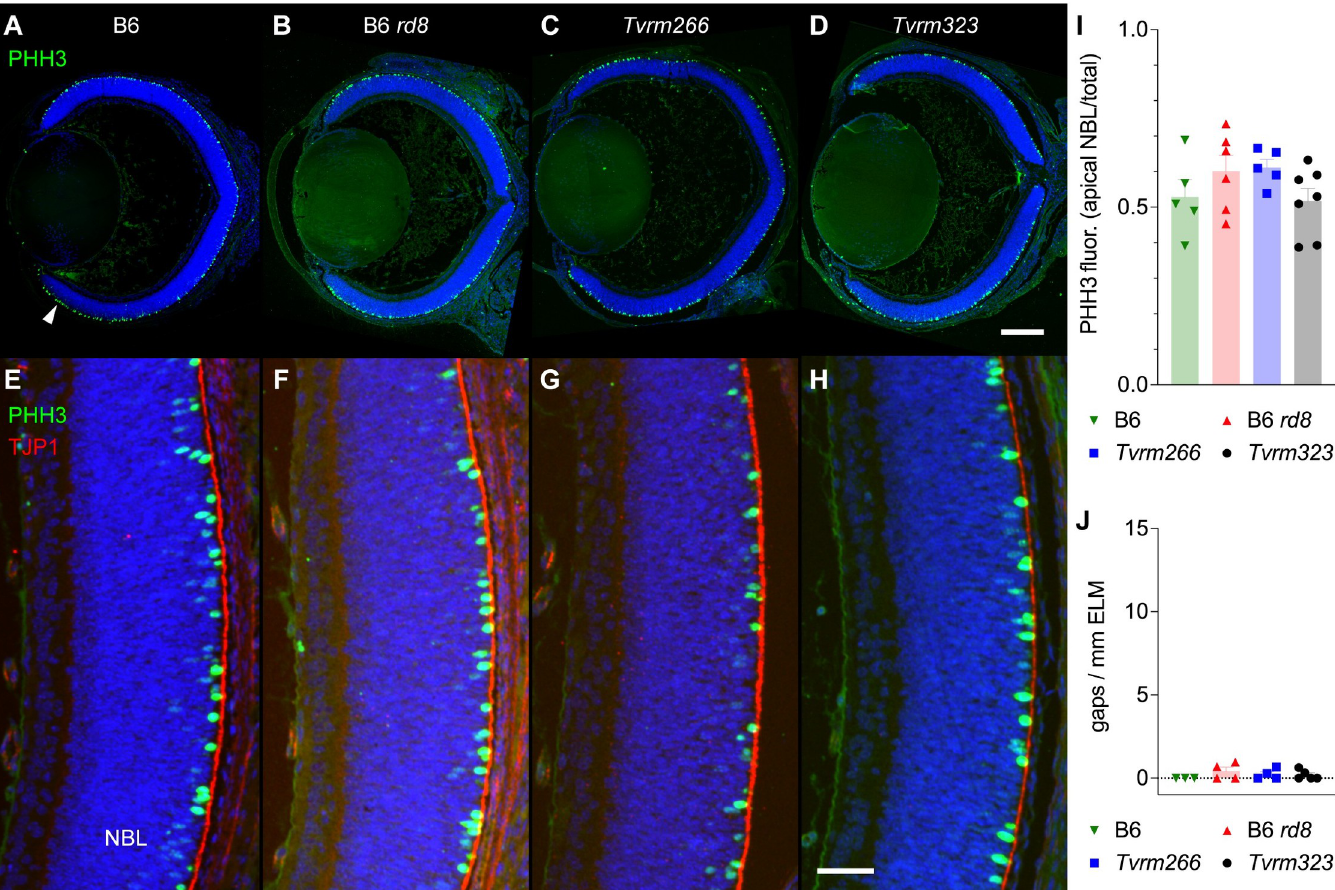
Fig 8. Distribution of mitotic progenitor cells at P0. A–D. Representative ocular sections of B6 (n = 5), B6 rd8 (n = 6), Tvrm266 (n = 5), or Tvrm323 (n = 7) mice, respectively, were probed with antibodies against phosphohistone H3 (PHH3, red ) to detect mitotic cells and DAPI ( blue ) to detect nuclei. A similar distribution of PHH3-positive staining within the outer NBL (A, arrow ) was observed in all strains. E–H. Detail of P0 retinas stained as in A–D and with antibody against TJP1 ( red ). The order of samples is the same as in A–D. Placement of progenitor cells undergoing mitosis close to the apical boundary of the NBL, delineated by TJP1, was observed in all strains. NBL, neuroblastic layer. Scale bars: D, 0.25 mm, applies to A–D; H, 50 μ m, applies to E–H. I. Quantitation of PHH3 fluorescence in a 20 μ m-wide band at the apical NBL relative to the total NBL. J. Quantitation of gaps per mm of the prospective ELM. Bars in I and J indicate mean ±